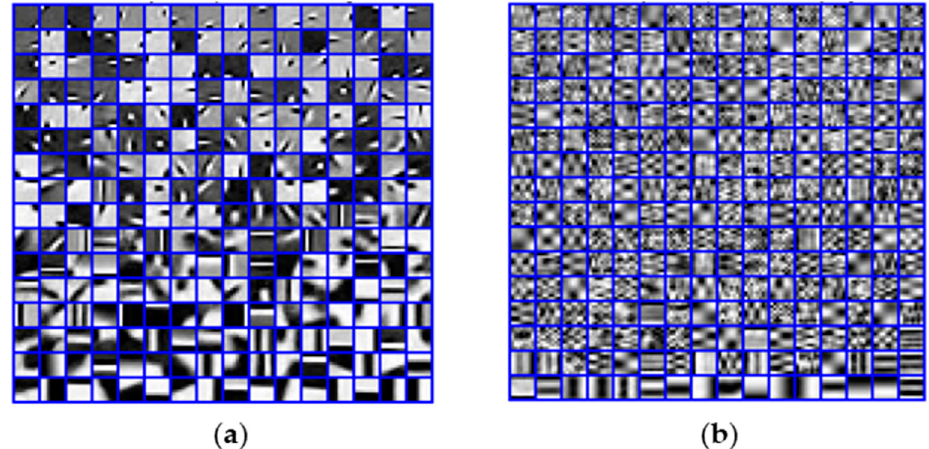
Figure 5. The random collections of 16 × 16 atoms ( K = 256) of trained dictionary from ( a ) a reference set of 3245 ultrasound images and ( b ) a noisy image.